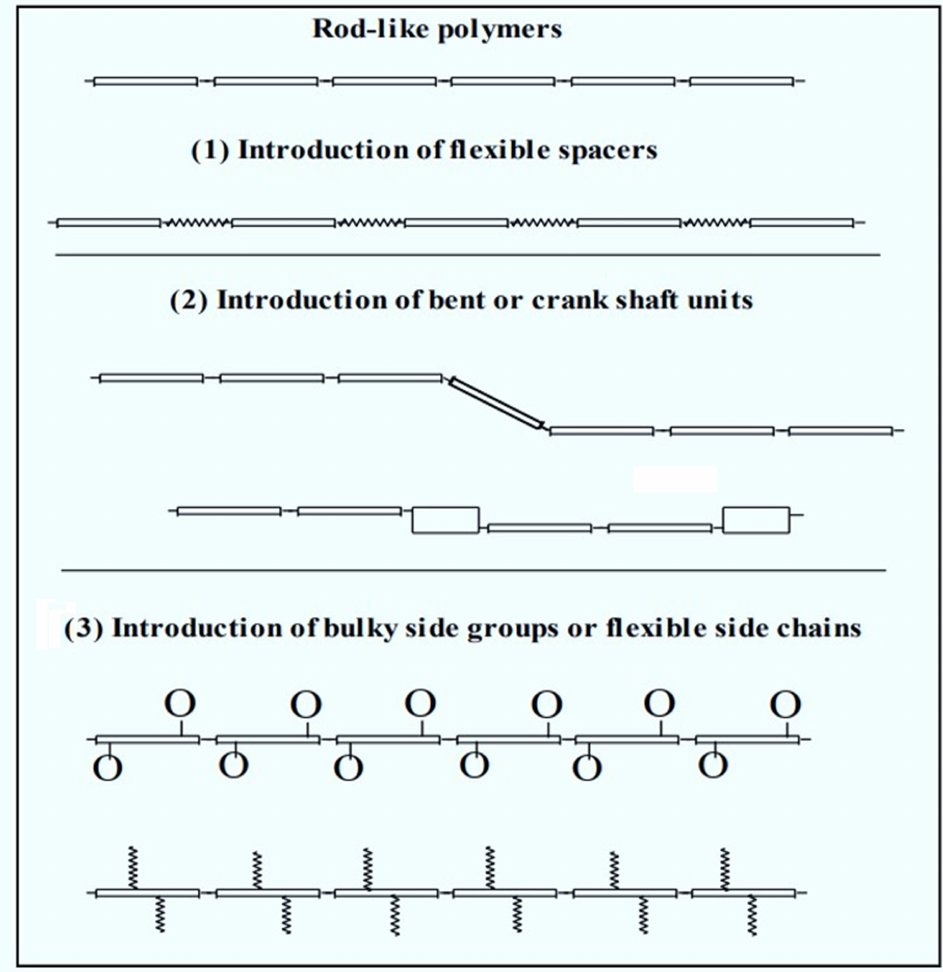
Figure 2. Macromolecular approaches for improving processability of high-performance